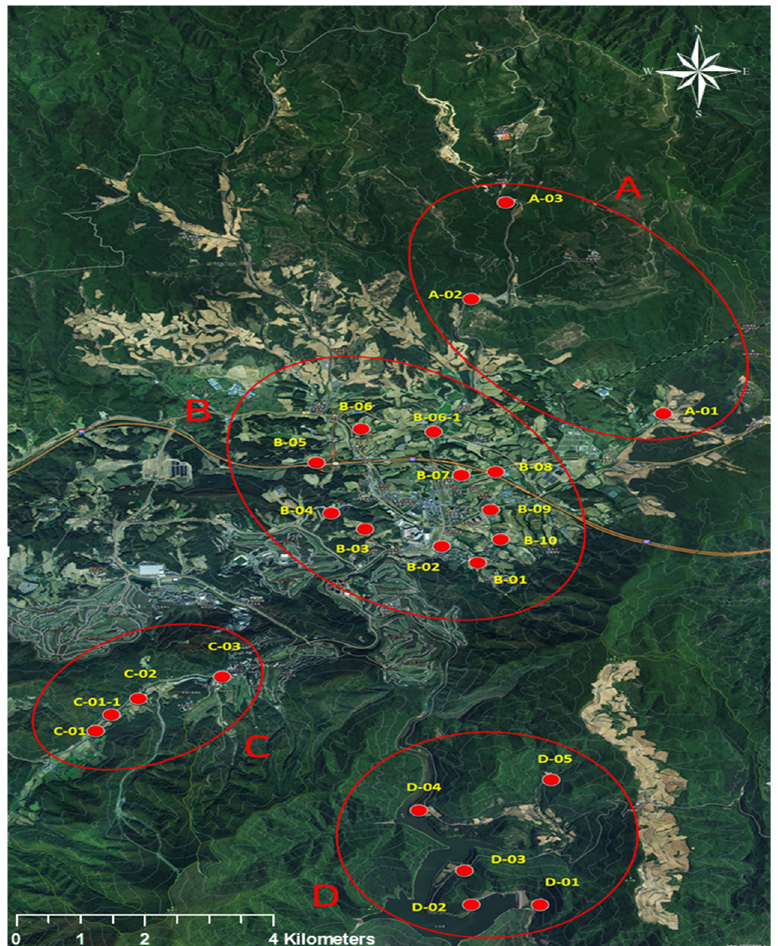
Figure 5. Field survey sites of the Doam Basin; (A) sheep ranches and forest, (B) city and highlands, (C) ski resort, highlands, and forest along the river, (D) forest and the Doam dam.